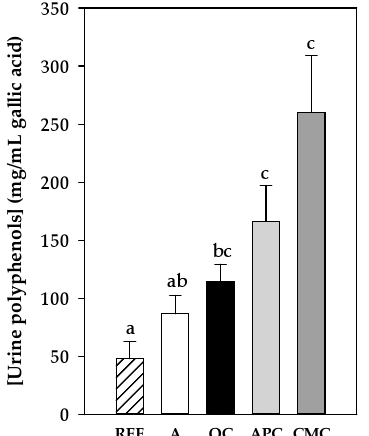
Figure 2. Polyphenol content (expressed as µ g / mL gallic acid) in urine samples at the end of the study. REF: healthy reference group fed standard diet; A: asthmatic group fed standard diet OC: asthmatic animals fed with ordinary cocoa-enriched diet; APC: asthmatic animals fed with “Amazonas